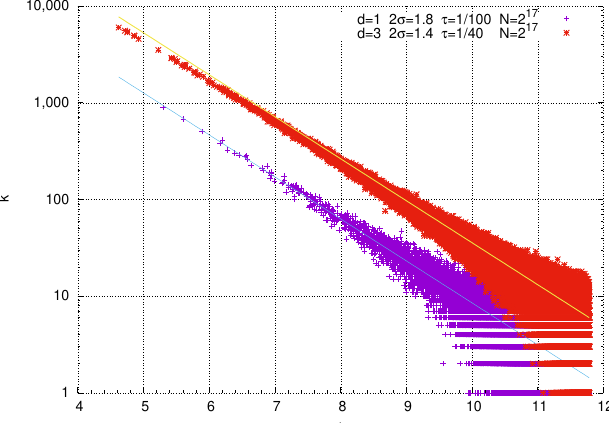
Figure 1. Comparison of (the asymptotic approximation to) Equation (29) (the two straight lines) with two sample N = 2 17 node networks generated from the model. The degree of each node u is plotted as a function of its (rescaled) radial coordinate η u , for a network sprinkled into H d + 1 . The lower data points, in red, come from a network with parameters d = 1, 2 σ = 9/5 and τ = 1/100, while the upper data points, in black, arise from a sprinkling with d = 3, 2 σ = 7/5 and τ = 1/40. In each case, we sprinkle into a ball of radius R H = ln N ≈ 11.78 (i.e., ν ≡ 1). Note that the vertical axis is in logscale, so that the exponential decay of node degree with distance η appears as straight lines. The simulation results appear to be consistent with Equation